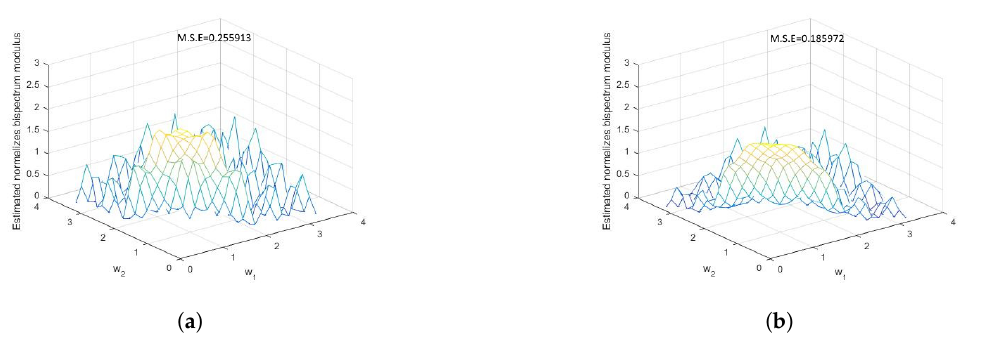
Figure 11. The estimated normalized bispectrum modulus using Parzen window. ( a ) Generated observations. ( b ) Forecasted